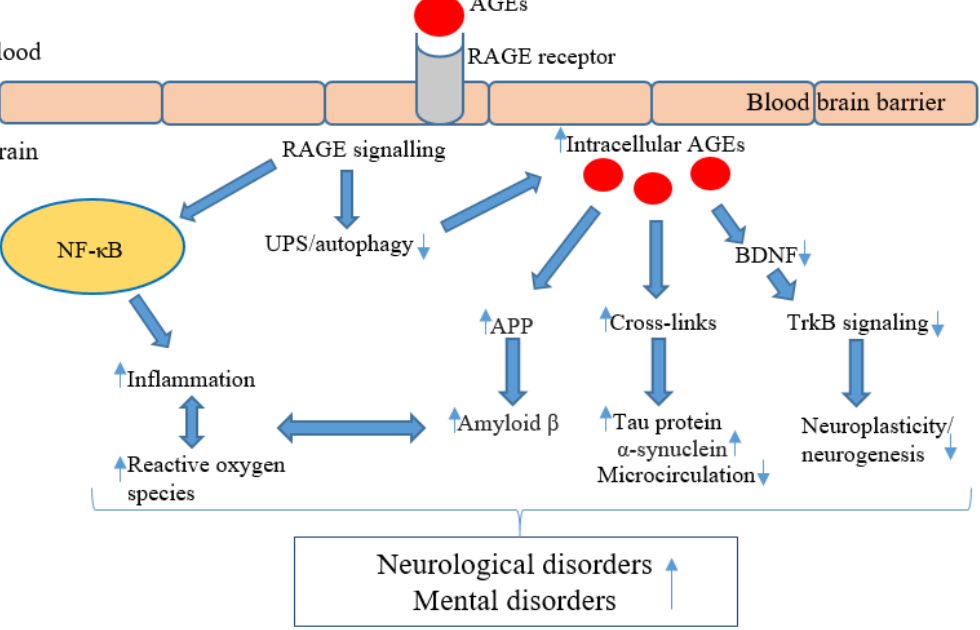
Figure 1. Molecular pathways underpinning the effects of AGEs in the pathogenesis of neuro- logicognitive and mental disorders. AGEs bind to the RAGE receptor located on the blood–brain barrier, which allows AGEs to enter the brain and to also activate RAGE signalling [98]. RAGE signalling activates nuclear factor kappa B (NF- κ B) within glial cells, resulting in the activation of pro-inflammatory cytokines and reactive oxygen species (ROS) production within the brain [77]. The neuroinflammation and ROS support amyloid beta ( β ) production and promote neuronal cell death [85]. RAGE signalling and production downregulates specific AGE detoxification pathways, involving the ubiquitin–proteasome system (UPS) and autophagy [26,83]. This impaired detoxifi- cation further contributes to intracellular AGEs accumulation and upregulating amyloid precursor proteins (APP), leading to amyloid β production [85]. AGEs form cross-links with aggregate tau protein and alpha-synuclein [63,99], in addition to possibly impairing the brain’s microstructure through protein cross-links [91]. AGEs may reduce the brain-derived neurotrophic factor (BDNF) and tropomyosin receptor kinase B (TrkB) signalling pathway, thereby impairing neuroplasticity [87]. ↑ = increase/upregulate, ↓ =